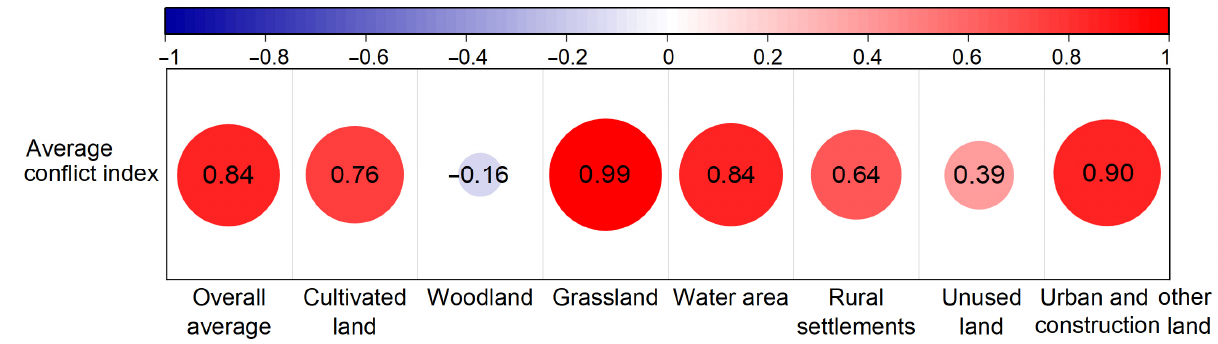
Figure 13. Pearson correlation coefficients between average conflict index and land use comprehen- sive dynamic degrees.